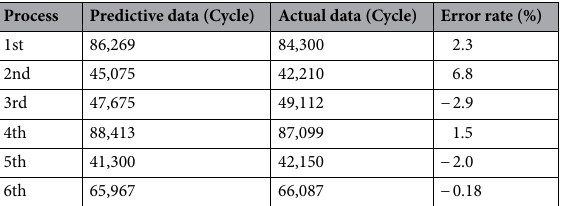
Table 6. Quantitative evaluation result based on real-time forming load